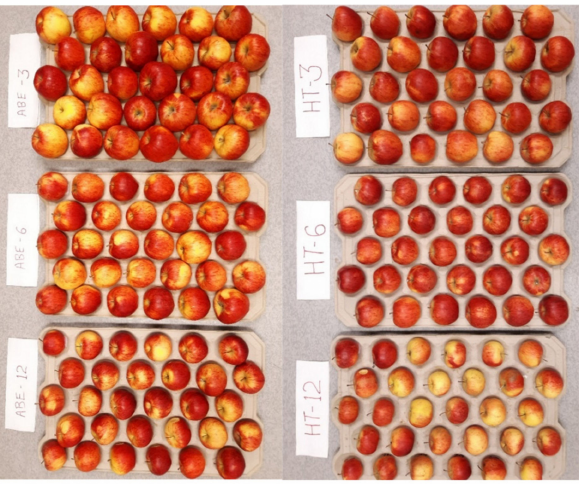
Figure 4. Photos showing the effect of thinning method and different crop loads on average fruit size. The fruit yield varied significantly with the crop load in both seasons ( p < 0.001)